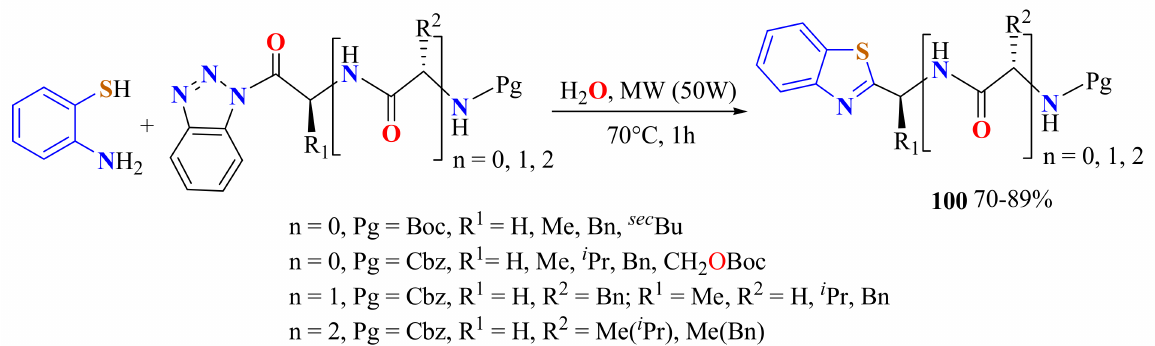
The same “suspension-in-water” protocol was used in the coupling of ATP with peptidylbenzotriazolides to afford 2-peptidylBTs 100a – o in 70–89% yields (Scheme 82).